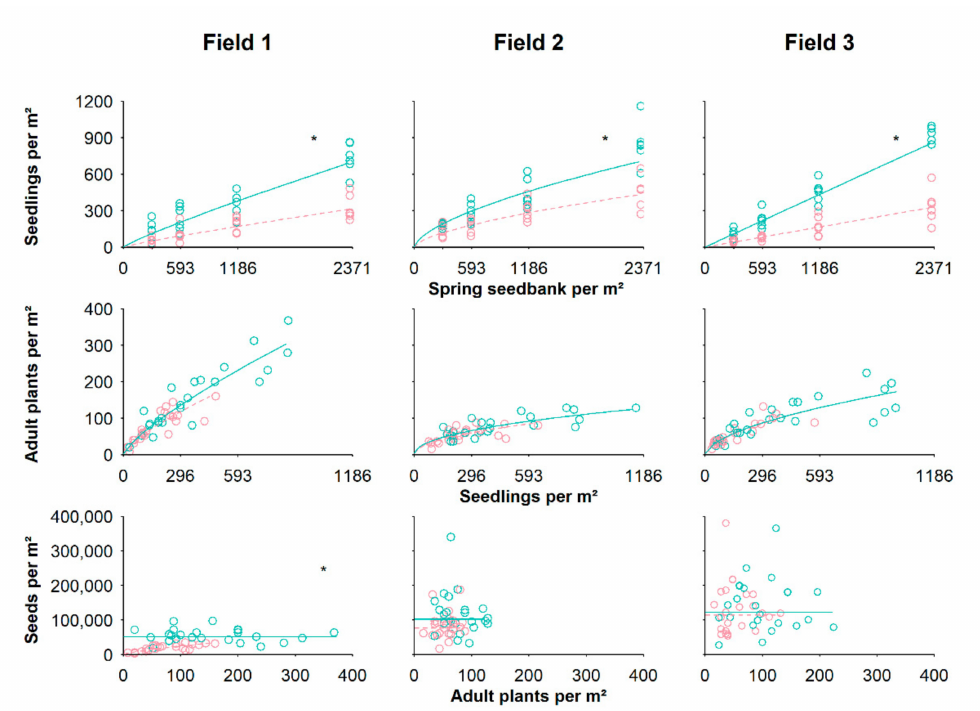
Figure 1. Back-transformed linear regression models showing the responses of transitions between life stages of Echinochloa crus-galli , i.e., seedling emergence, seedling survival, seed production m − 2 , to seed predation (red circles and dashed line) over the winter vs. no seed predation (green circles and solid line) over the winter, as a function of E. crus-galli density, in three maize fields in north-eastern Germany ( n = 6). Panels labelled (*) indicate a significantly different ( p < 0.05) response to seed predation.